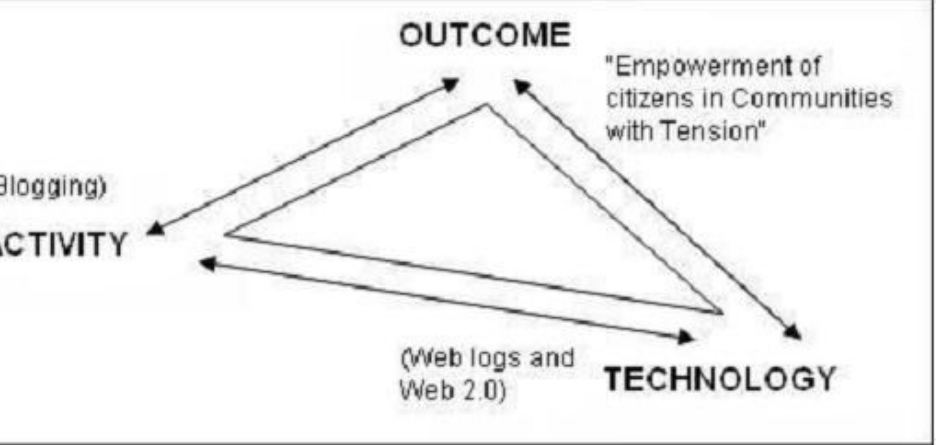
Figure 1 Triad model adapted from Ehrmann